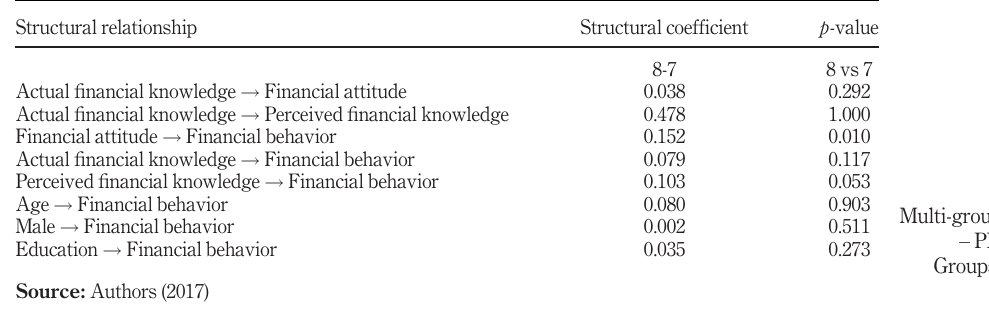
Table IX. Multi-group analysis – PLS-MGA